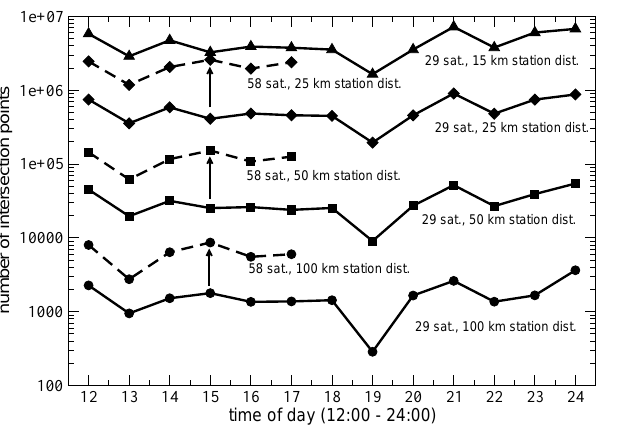
Fig. 4. The number of intersection points increases with the num- ber of ray paths according to ∼ 0 . 000137 · N 2 ray . The ray paths have been computed for an increasing number of ground stations and two different satellite constellations with 29 ( • ) and 58 ( (cid:4) )